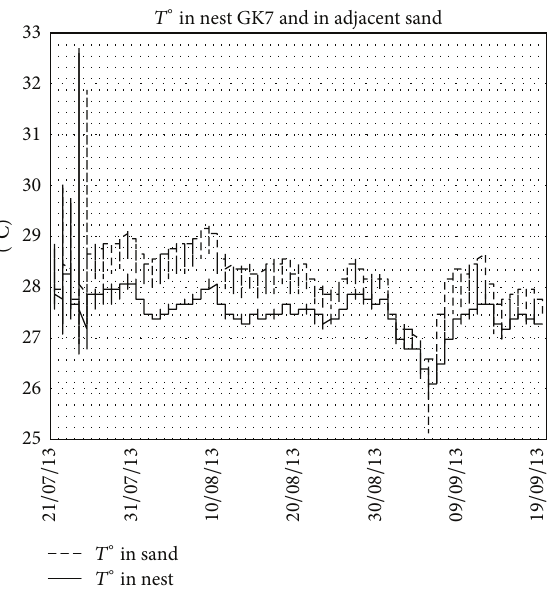
Figure 3: Temperatures in nest GK7 (with a majority of unhatched eggs) and in adjacent sand. Note the nest temperature is lower than outside temperature, lacking metabolic